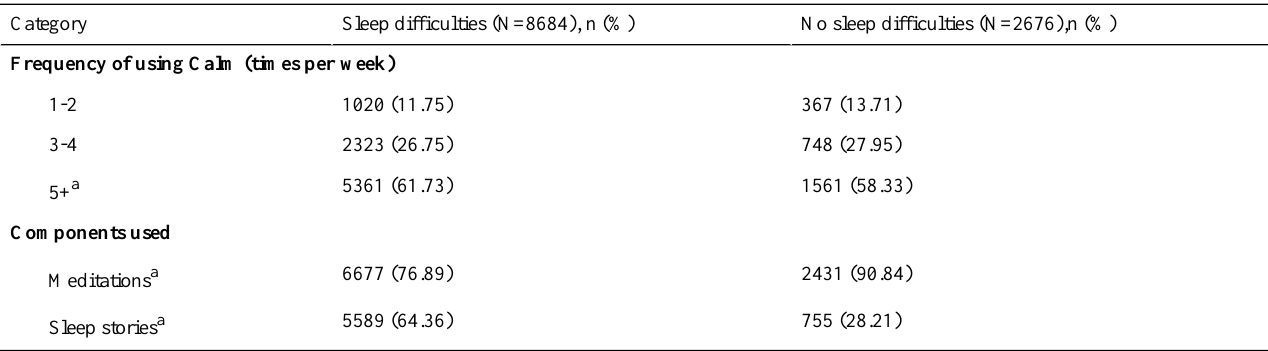
Table 6. Differences in the frequency of using Calm, frequency of using meditations and Sleep Stories, and reasons for starting to use Calm based on reported sleep difficulties